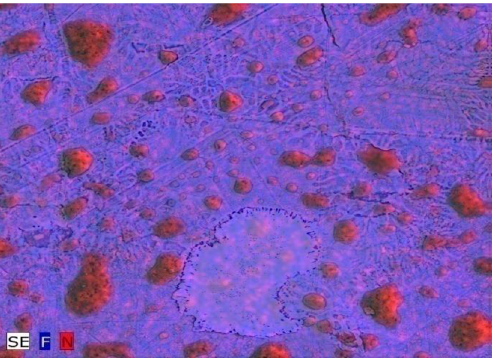
Figure 9. EDX mapping with fluorine (blue) and nitrogen (red) labeling in PFA specimens attacked with MDI for 120 h.